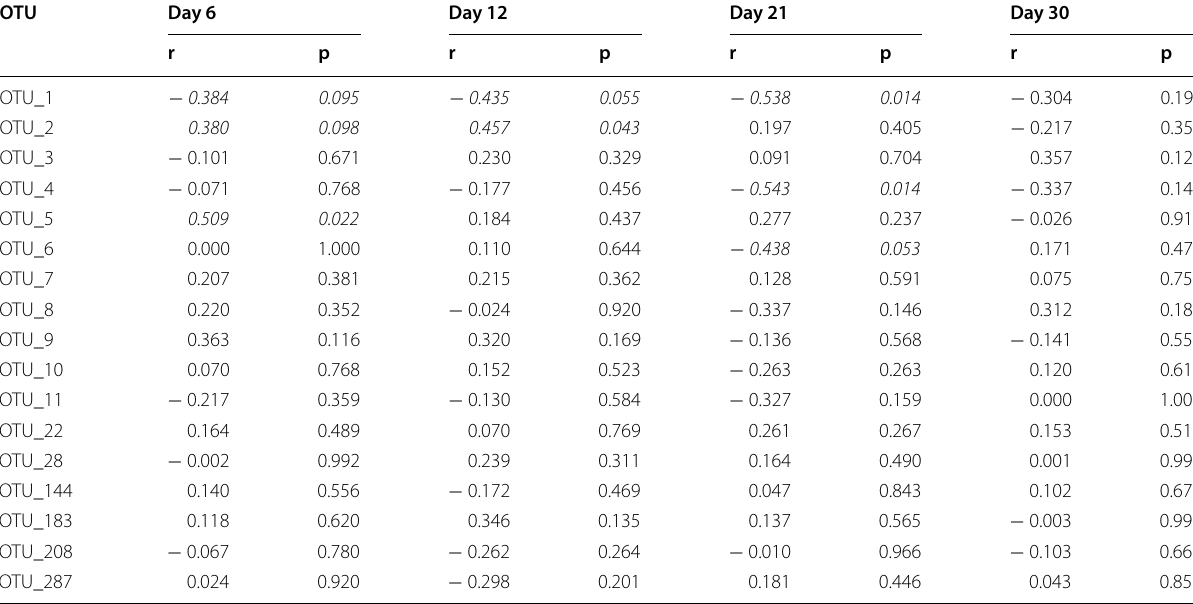
Significant ( p < 0.05) and marginally significant ( p < 0.1) differences were indicated in italics Table 2 The correlation between zinc leaching efficiency on day 30 and individual physicochemical parameter at differ- ent stages